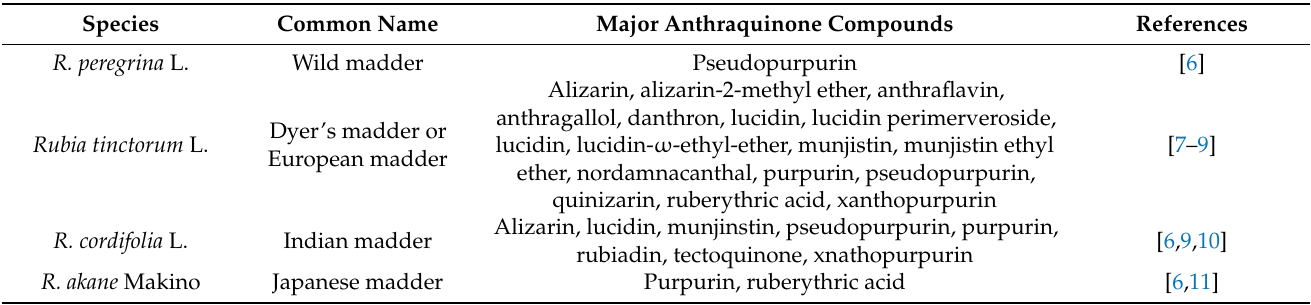
Figure 3. Some of the anthraquinone derivatives isolated from Rubia cordifolia . Purpurin (1), pseu- dopurpurin (2), xanthopurpurin (3), alizarin (4), munjistin (5), lucidin (6), lucidin primeveroside (7), lucidin- Ω -ethyl-ether (8), nordamnacanthal (9), pachybasin (10), quinzarin (11), rubiadin (12), ruberythric acid (13), tectoquinone (14), anthragallol (15), danthron (16), anthrafalvin (17), alizarin- 2-methyl-ether (18) (structures of metabolites were drawn by authors). Table 1. Naturally occurring anthraquinonoid pigments in Rubia species.